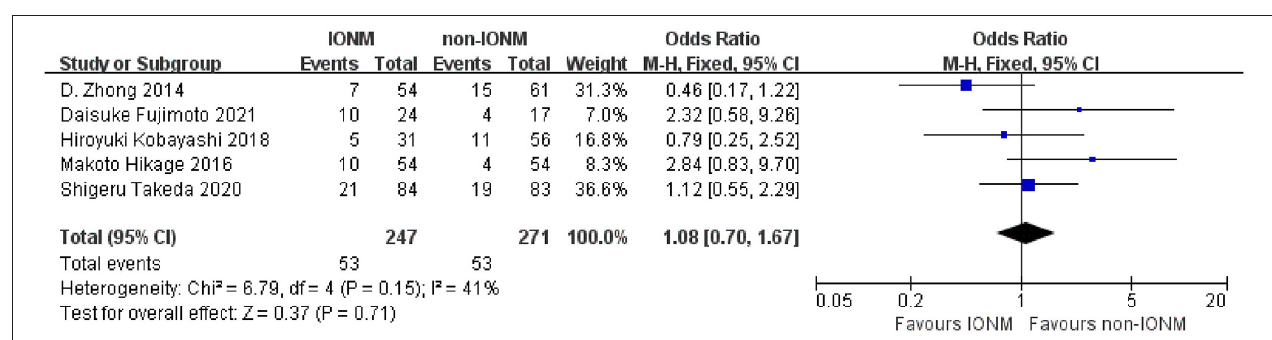
FIGURE 7 | Forest plot of pneumonia in the IONM and non-IONM groups.